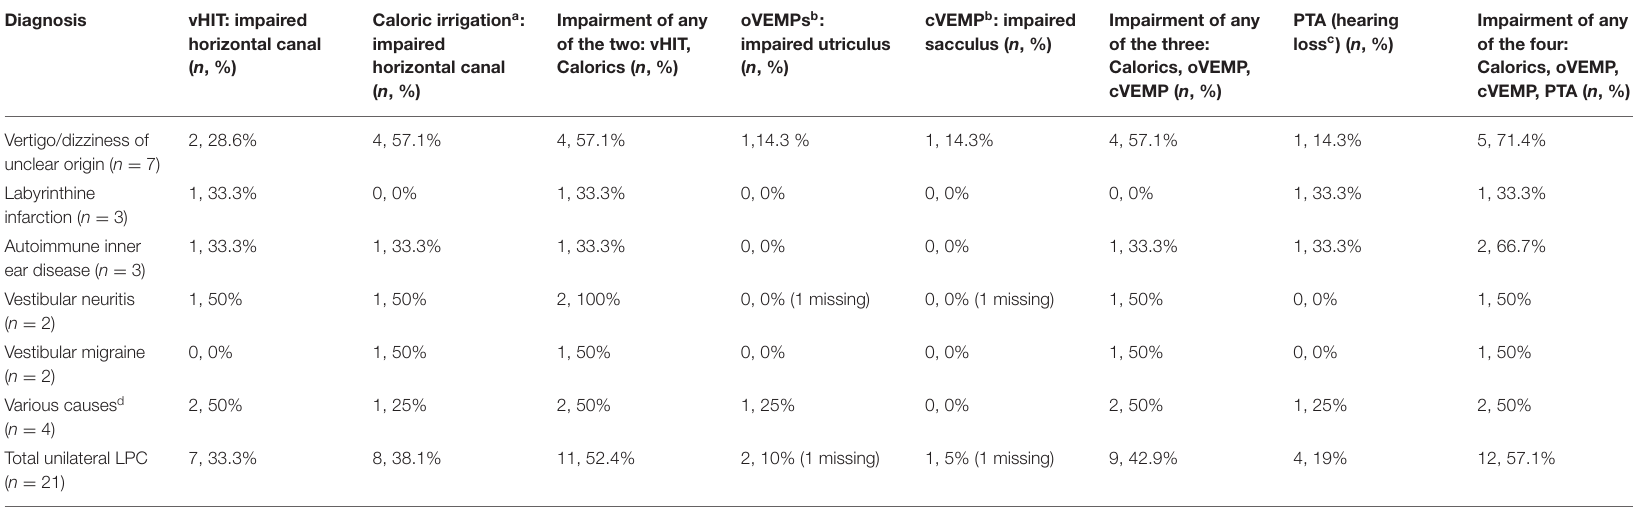
TABLE 2 | Ipsilesional vestibulo-cochlear involvement in patients with unilateral LPC on